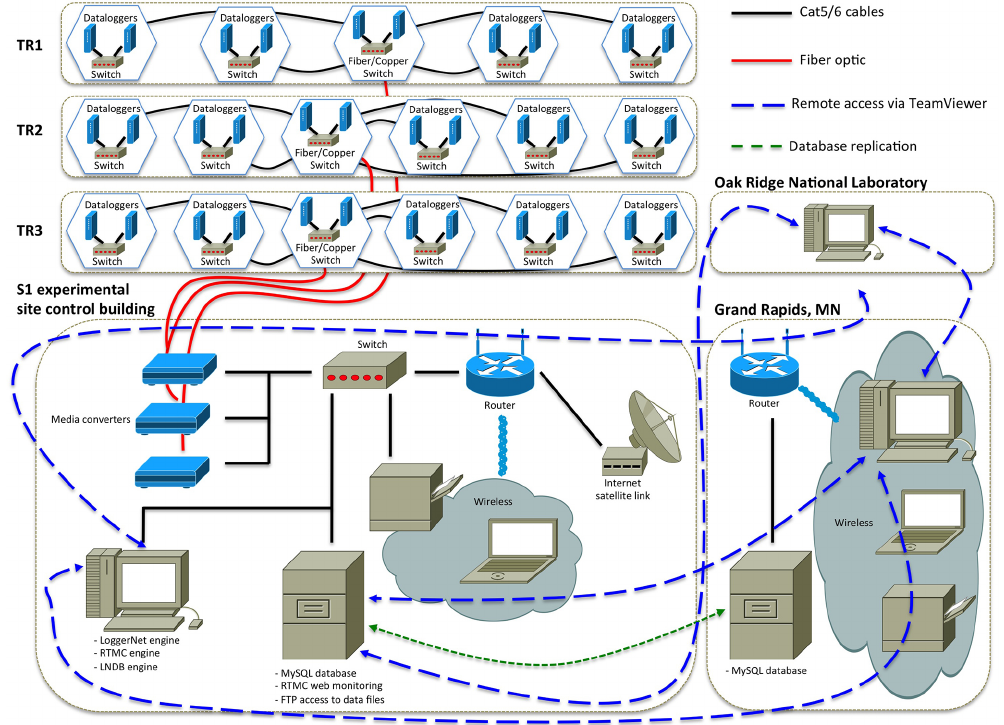
Figure 5. SPRUCE data collection and monitoring system.